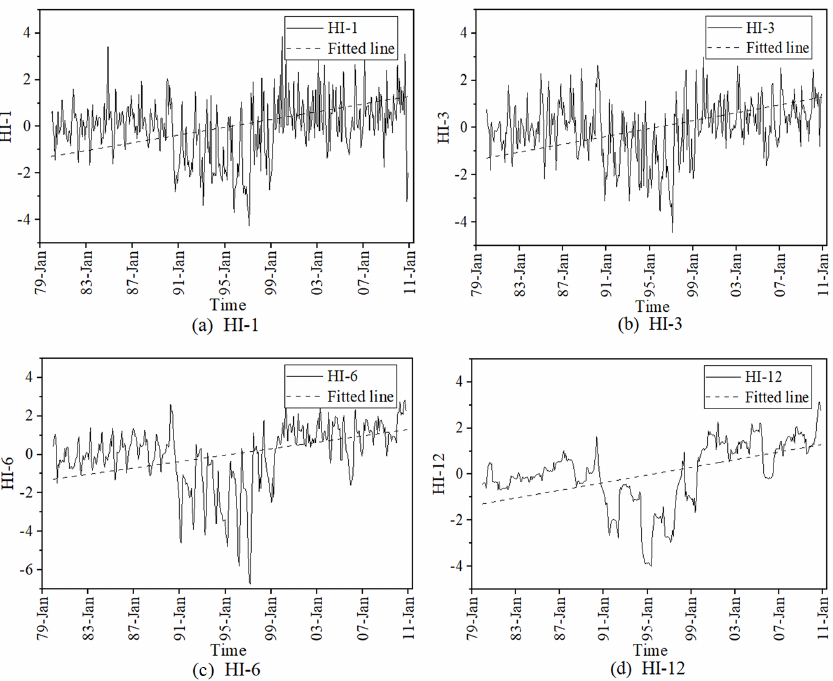
Figure 5. Different average periods of the HI (HI-1: HI with a 1-month timescale; HI-3: HI with a 3-month timescale; HI-6: HI with a 6-month timescale; HI-12: HI with a 12-month timescale).